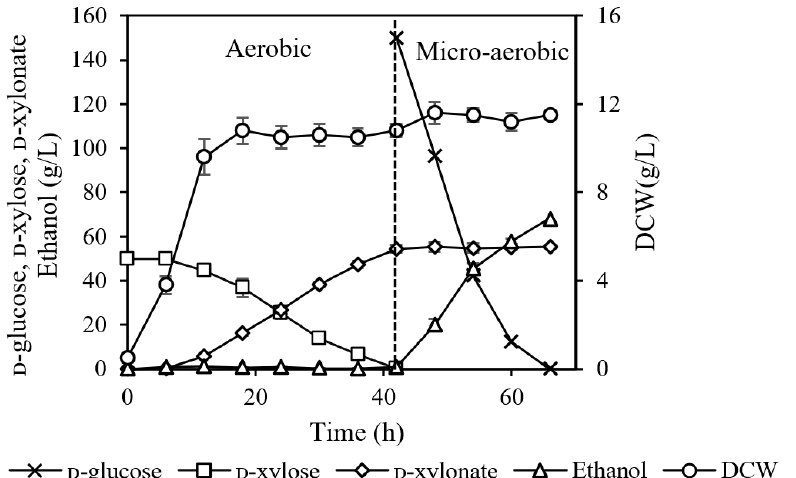
Figure 2. Sequential production of ᴅ -xylonate and ethanol from pure ᴅ -xylose and ᴅ -glucose medium by a two-stage fermentation.